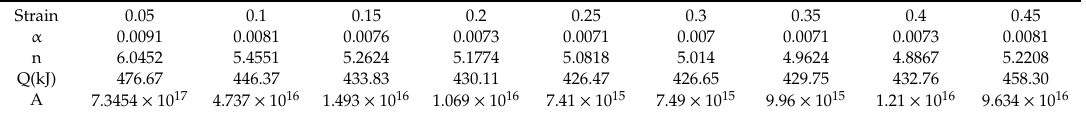
. ε Figure 5. ( a ) ln σ − ln𝜀(cid:4662) plot and ( b ) ln (cid:4670)sinh(cid:4666)𝛼𝜎(cid:4667)(cid:4671) − (cid:4666) (cid:2869) Figure 5. ( a ) ln σ − ln plot and ( b ) ln [ sinh ( ασ )] − Table 1. Parameters obtained for the Arrhenius-type constitutive